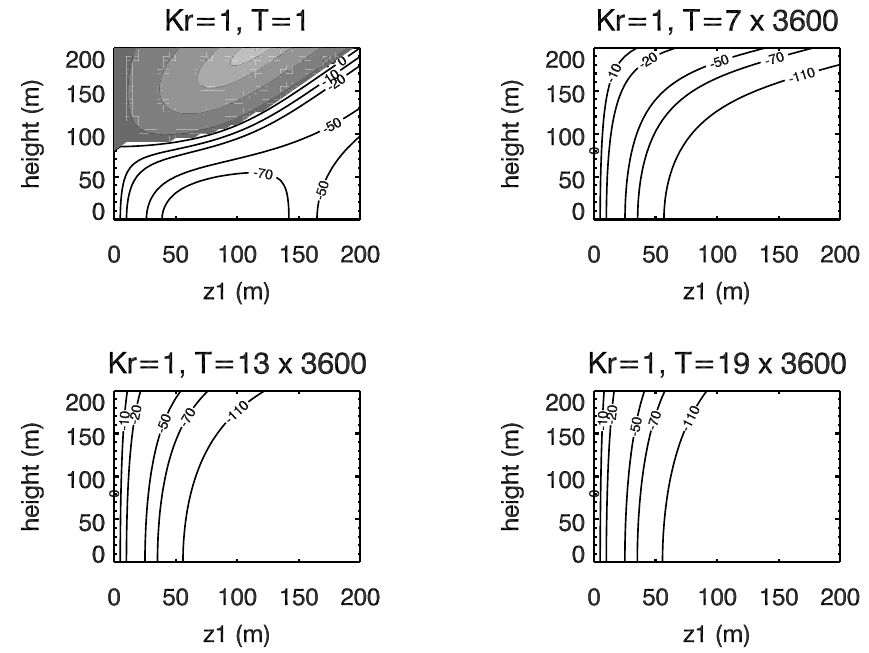
Figure 1. Distribution of ∂ ˜ G 1 d / ∂ z (cid:48) on the z − z (cid:48) plane with K t = 1 and a wide range of T . Contours with a positive value are shaded.